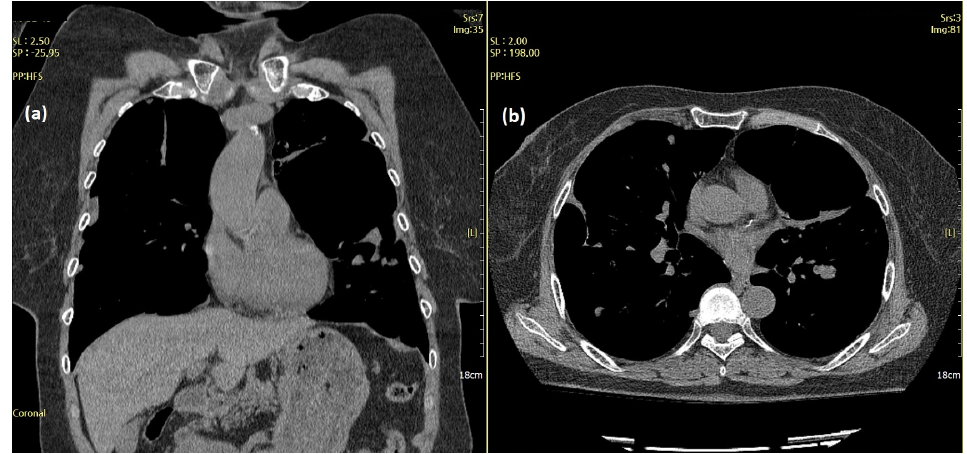
Figure 5. Follow-up computed tomography examination. Follow-up chest computed tomography showed improved disease status (August 2021). ( a ) Coronal and ( b ) axial views.